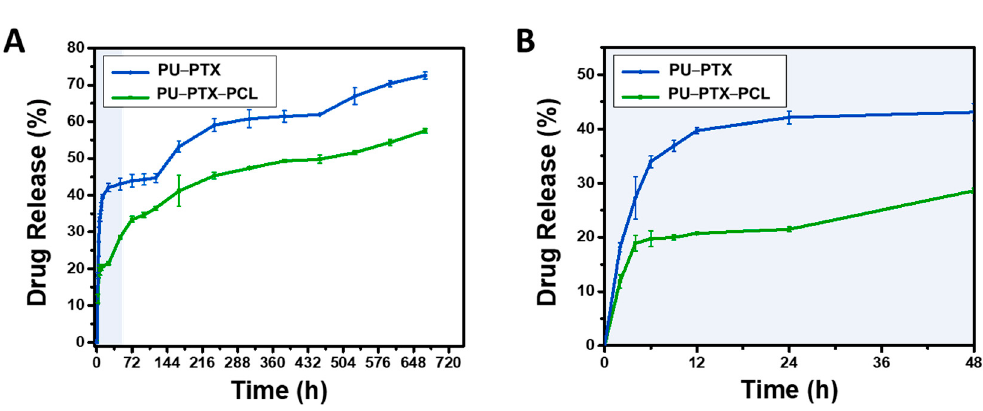
Figure 3. ( A ) The comparison of PTX release behavior between PTXloaded PU nanofibers enveloped with and without the PCL layer. ( B ) Initial 48 h measurement of PTX release profile. Three percent PTX is used in all samples.